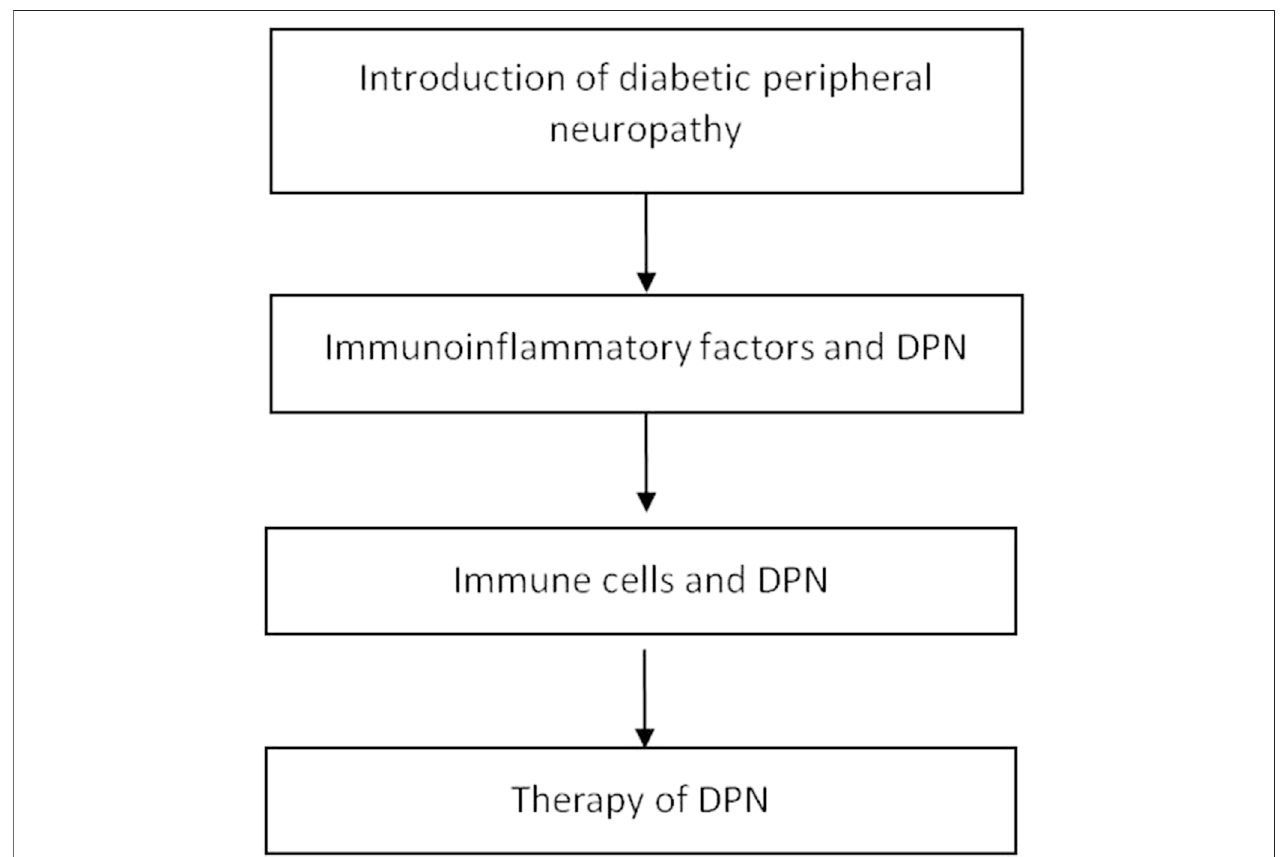
FIGURE1 | Schematic fl owcharts. Schematic fl owcharts of the article.